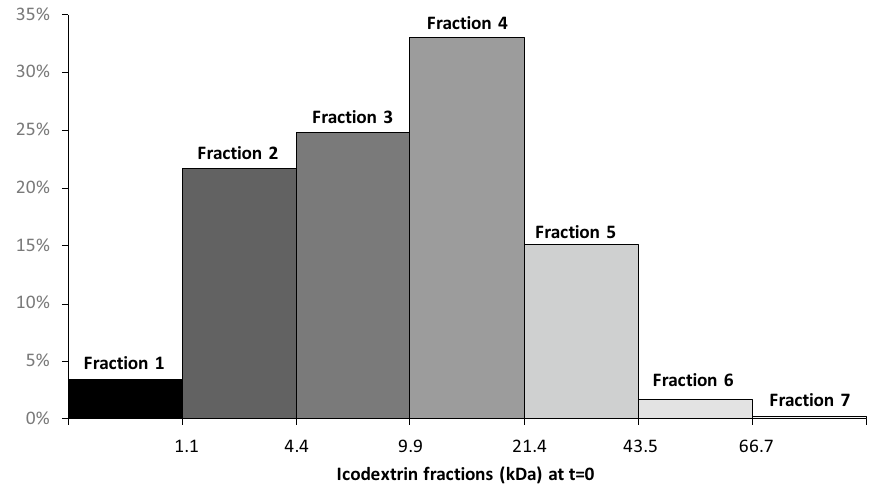
Figure 1. The relative (in percent) distribution of seven different molecular weight fractions in fresh icodextrin dialysis